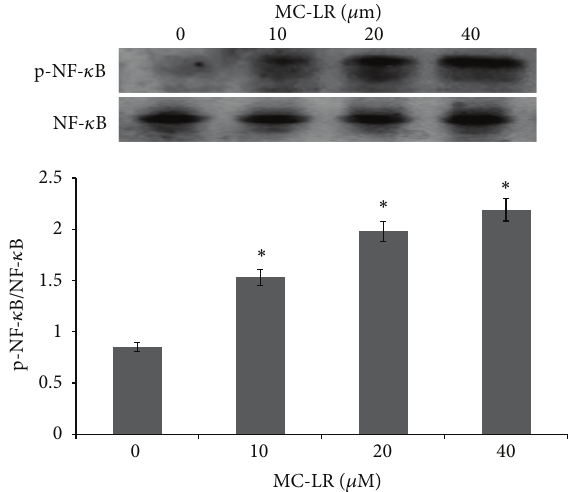
Figure 6: The MC-LR induced the expression of NF- 𝜅 B protein in